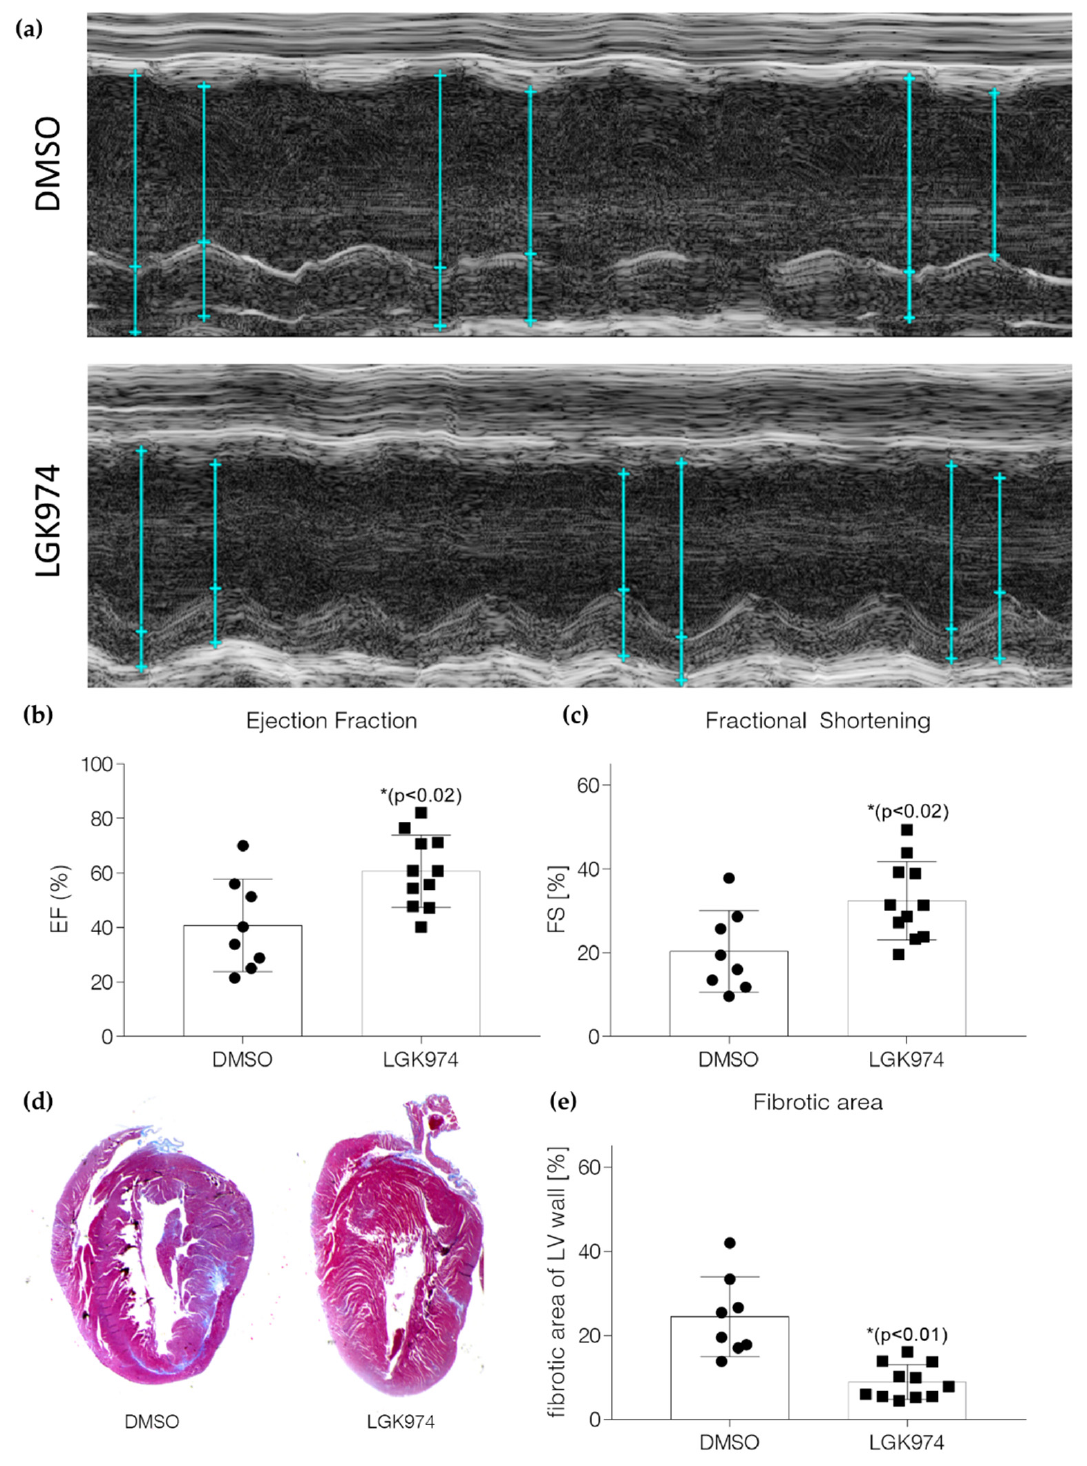
Figure 4. LGK-974 treatment during the inflammatory response following I/R injury improves heart function. ( a ) Representative M-Mode echocardiographic images of DMSO (top) and LGK-974 treated (bottom) animals. ( b , c ) Echocardiographic results from DMSO and LGK-974 treated animals. ( d ) Representative Masson trichrome staining of DMSO (left) and LGK974 (right) treated animals 4 weeks after I/R injury. ( e ) Quantification of the fibrotic area of the LV wall in DMSO resp. LGK974 treated animals. N = 8 for DMSO-treated animals and N = 11 for the LGK-974-treated animals.